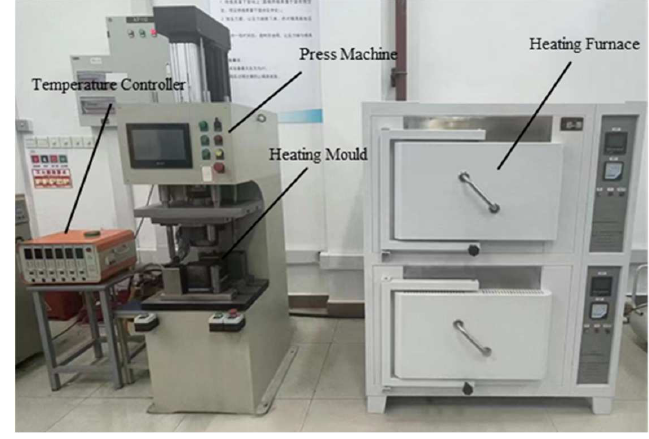
Figure 3. Experimental equipment for all three processes.